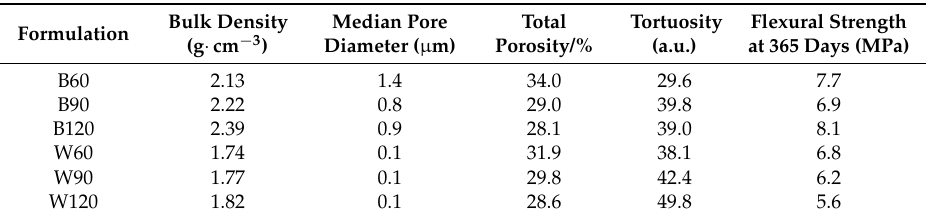
Table 3. Microstructural data as determined by MIP of all the formulations aged 28 daysand mechanical properties at 1 year aging.